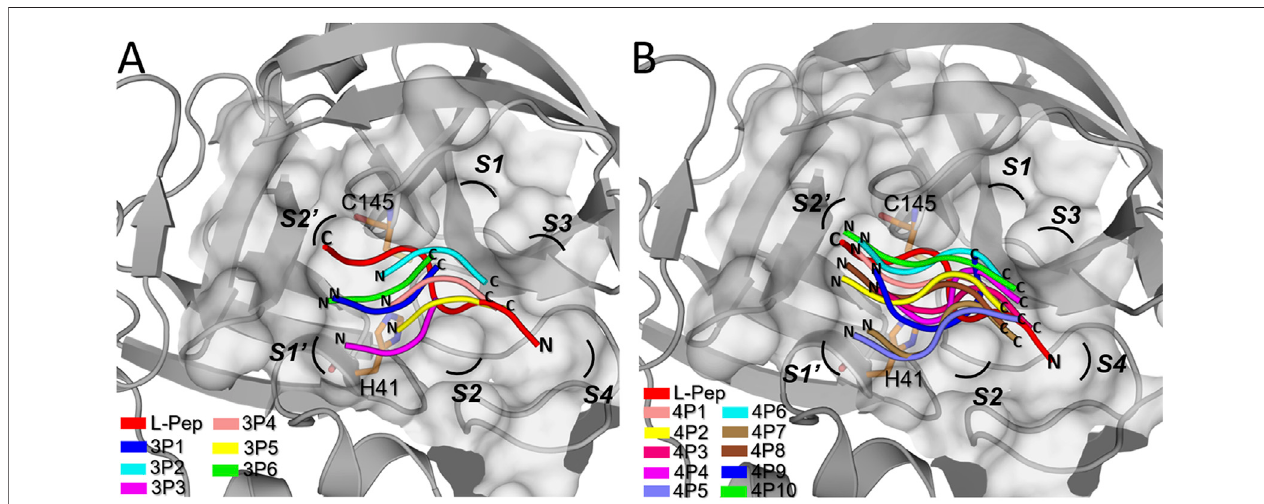
FIGURE 3 | Accommodation of the D-peptide backbones into the active site of 3CL pro . Superimposed central structures of 3CL pro in complex with the (A) D-tripeptides and (B) D-tetrapeptides proposed as potential inhibitors ( Table 1 ), determined from the respective 110 ns MD simulations. In both cases, the crystal structure of 3CL pro (PDB: 6Y2E) is depicted in gray and the catalytic residues, H41 and C145, are shown as orange sticks. The protease active site is represented as a gray surface. The D-peptides of the structurally-aligned complexes are colored differently (see legends). The 3CL pro conformation of each central structure was omitted for clarity ’ s sake. For comparison purposes, each panel shows the conformation of the L-peptide VTLQSK (L-Pep) into SARS-CoV-2 3CL pro , obtained through structural alignment between the former protease and the crystal structure of SARS-CoV 3CL pro (PDB: 5B6O) (Muramatsu, et al., 2016). L-Pep corresponds to the C-terminalportionofaneighboringSARS-CoV3CL pro chainthatinsertsinasubstrate-likeconformationintotheproteaseactivesite.LettersNandCindicatetheN-and C-termini of the peptides, respectively. The 3CL pro subsites S2 ′ to S4 are labeled